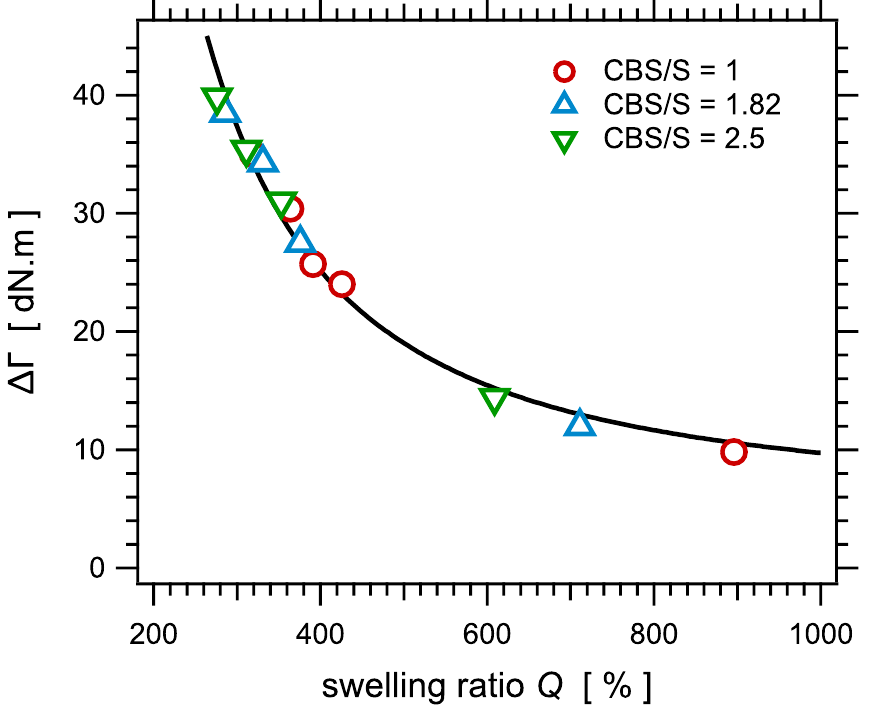
Figure 9. The torque increase ∆Γ during curing as a function of the equilibrium swelling ratio Q , for the series of samples with different amounts of sulfur and different sulfur/accelerator ratios. The curve is a fit with an equation similar to Equation